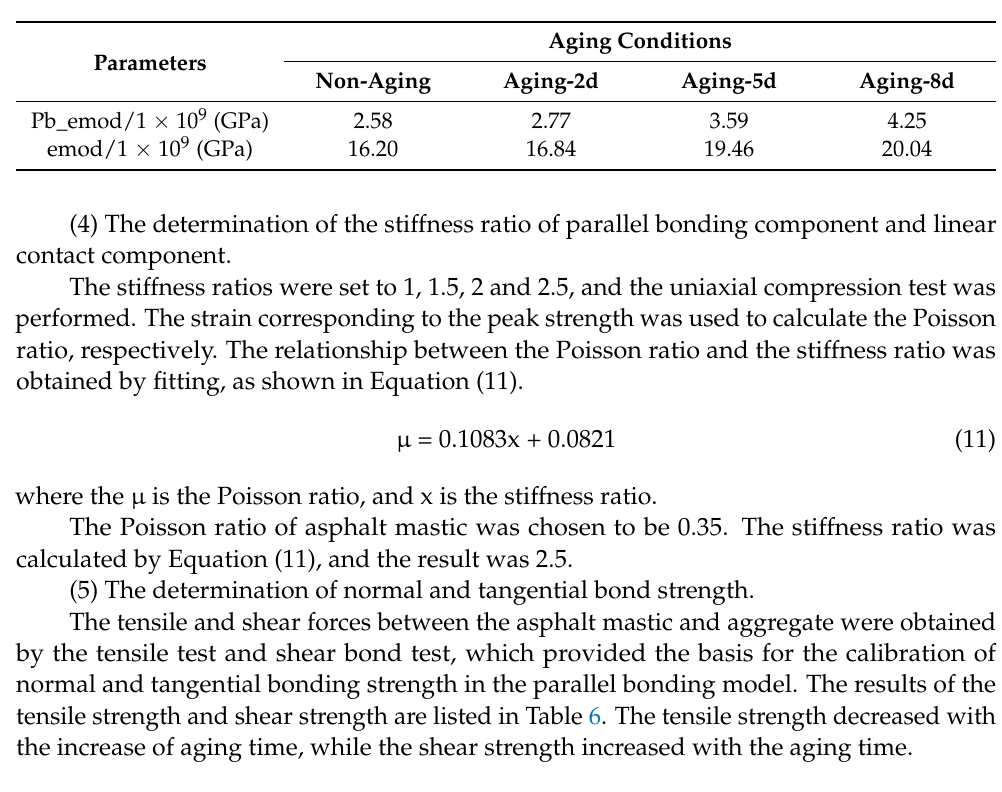
Table 6. Drawing strength and shear strength under different aging conditions. Strength